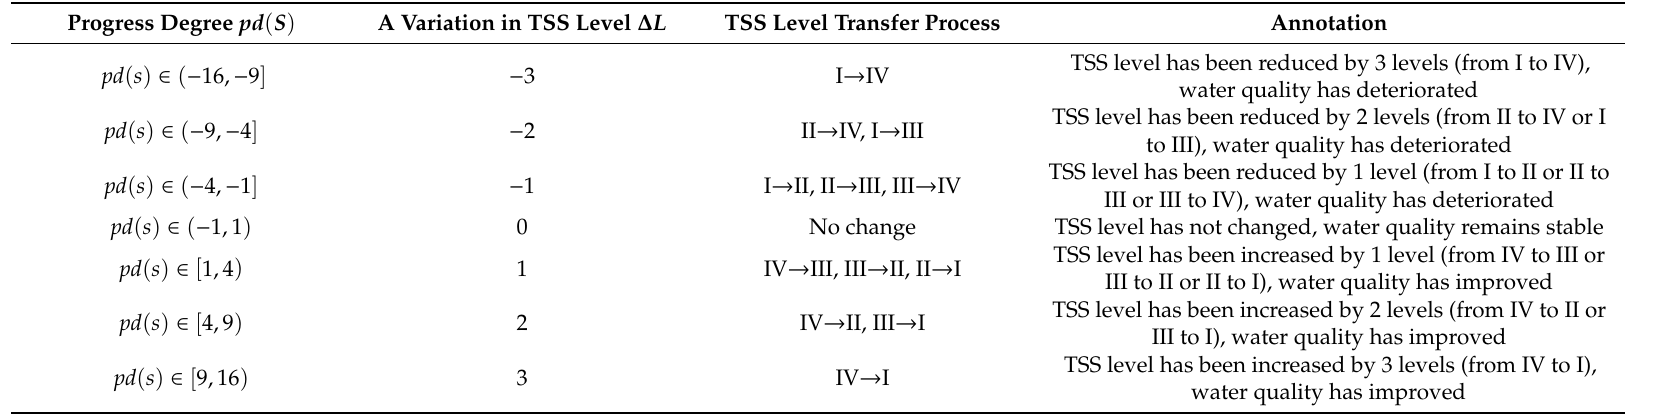
Table 3. The relationship between the progress degree ( pd ( S ) ) and the TSS level transfer progress is expressed by using the variation in the TSS level ( ∆ L ). Among them, pd ( S ) is the degree of progress calculated by the Markov model, which quantitatively describes the degree of change in the conversion between any two TSS concentration levels to indirectly reflect the water quality status of the water body; ∆ L is the di ff erence in the number of changes in the two TSS levels during the change in the TSS level status. Additionally, the division between TSS concentration levels is based on Chinese standards, mainly including 4 TSS levels, followed by